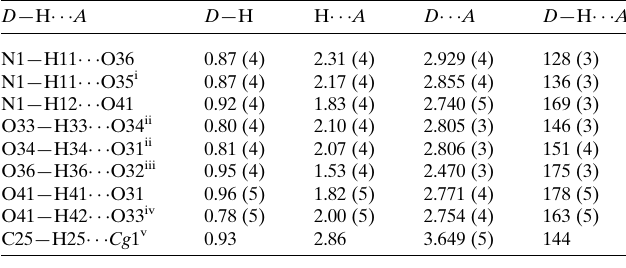
Table 3 Hydrogen-bond geometry (A˚ , (cid:4) ) for (III). Cg 1 represents the centroid of the ring (C21–C26).